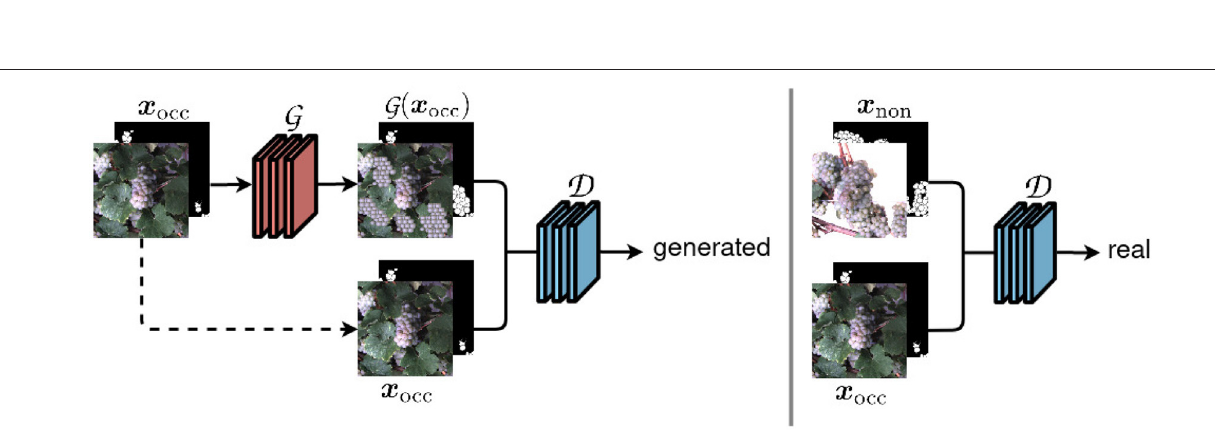
Frontiers in Artificial Intelligence |